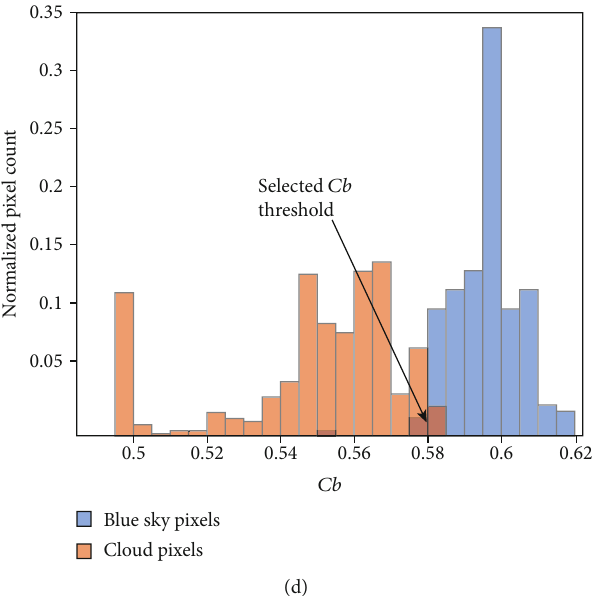
Figure 8: (a) Y , Cb , and Cr scattered plot, (b) Y and Cr scattered plot, (c) Cb and Cr scattered plot for blue-sky pixels and white and grey cloud pixels, and (d) normalized histogram of Cb component of blue-sky pixels and cloud pixels.